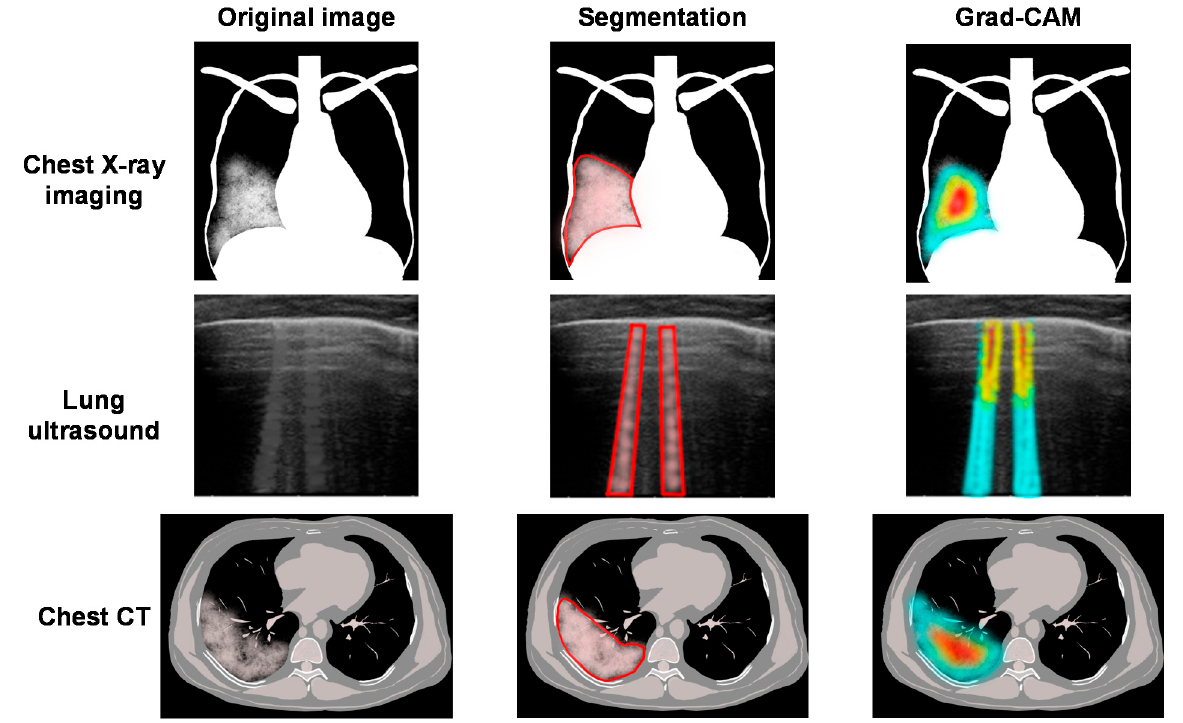
Figure 1. Segmentation and the gradient-weighted class activation mapping (Grad-CAM) have been used in various AI-based medical imaging analyses in COVID-19. Grad-CAM provides a clinically interpretable saliency map that indicates the discriminative regions of the image that determine the classification of the severity of COVID-19.